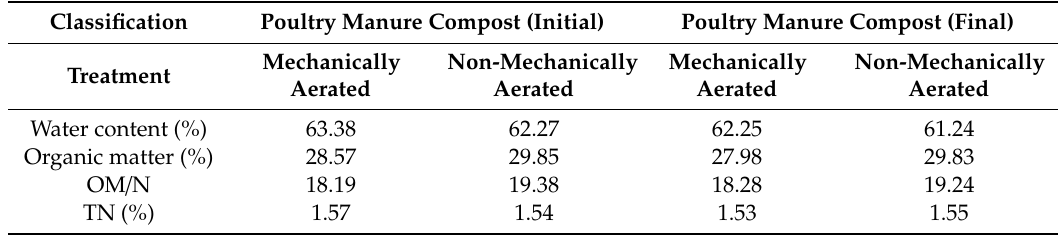
Table 1. Characteristics of poultry manure used in this study.